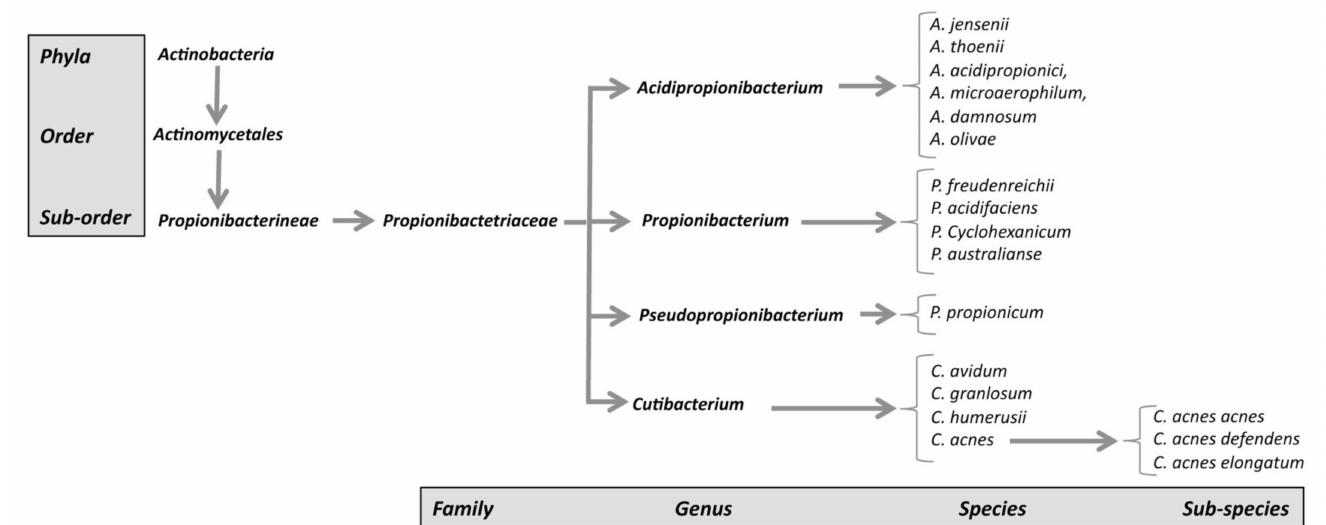
Figure 1. New classification of C. acnes